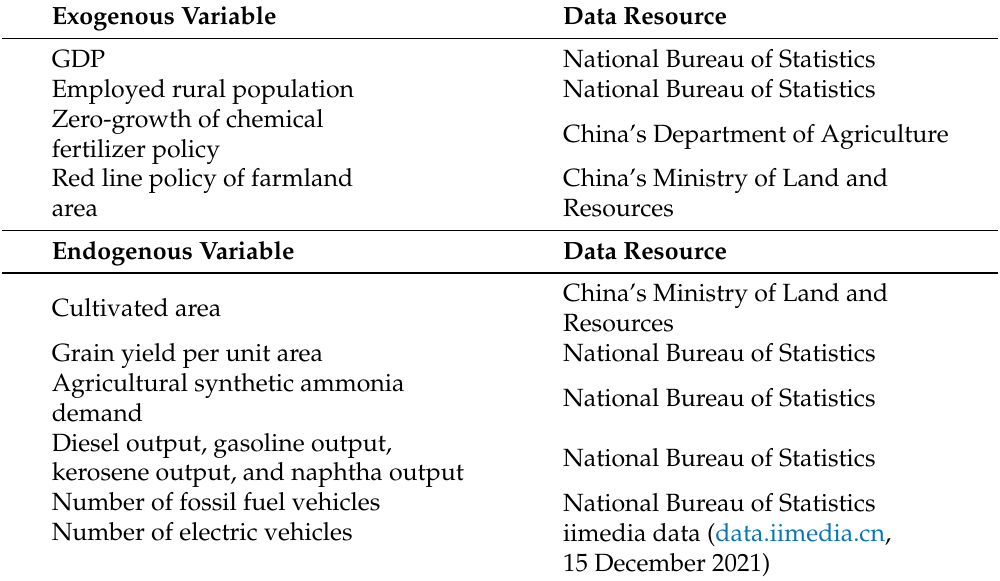
Table 6. Data resources of exogenous and endogenous